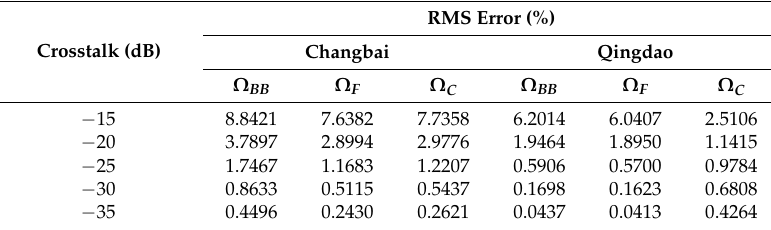
Table 10. RMS error ( σ RMS ) under the condition of crosstalk.